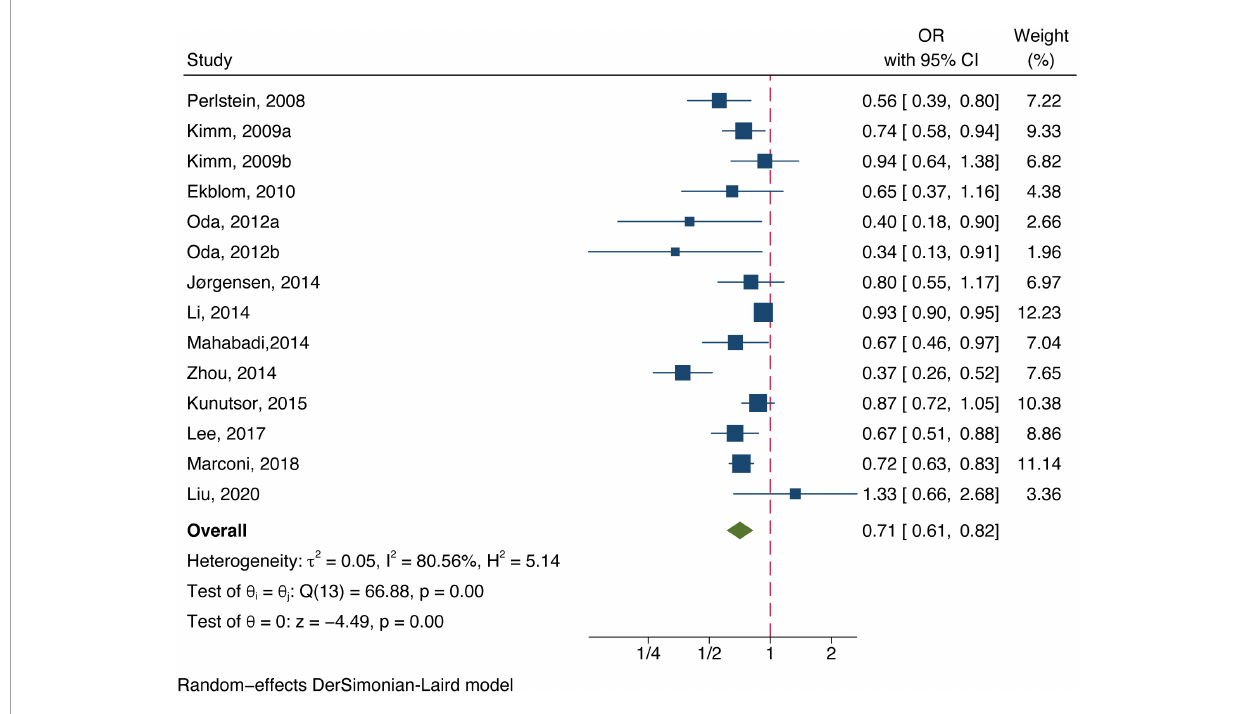
FIGURE2 Forest plot of the association between total bilirubin level and stroke prevalence.